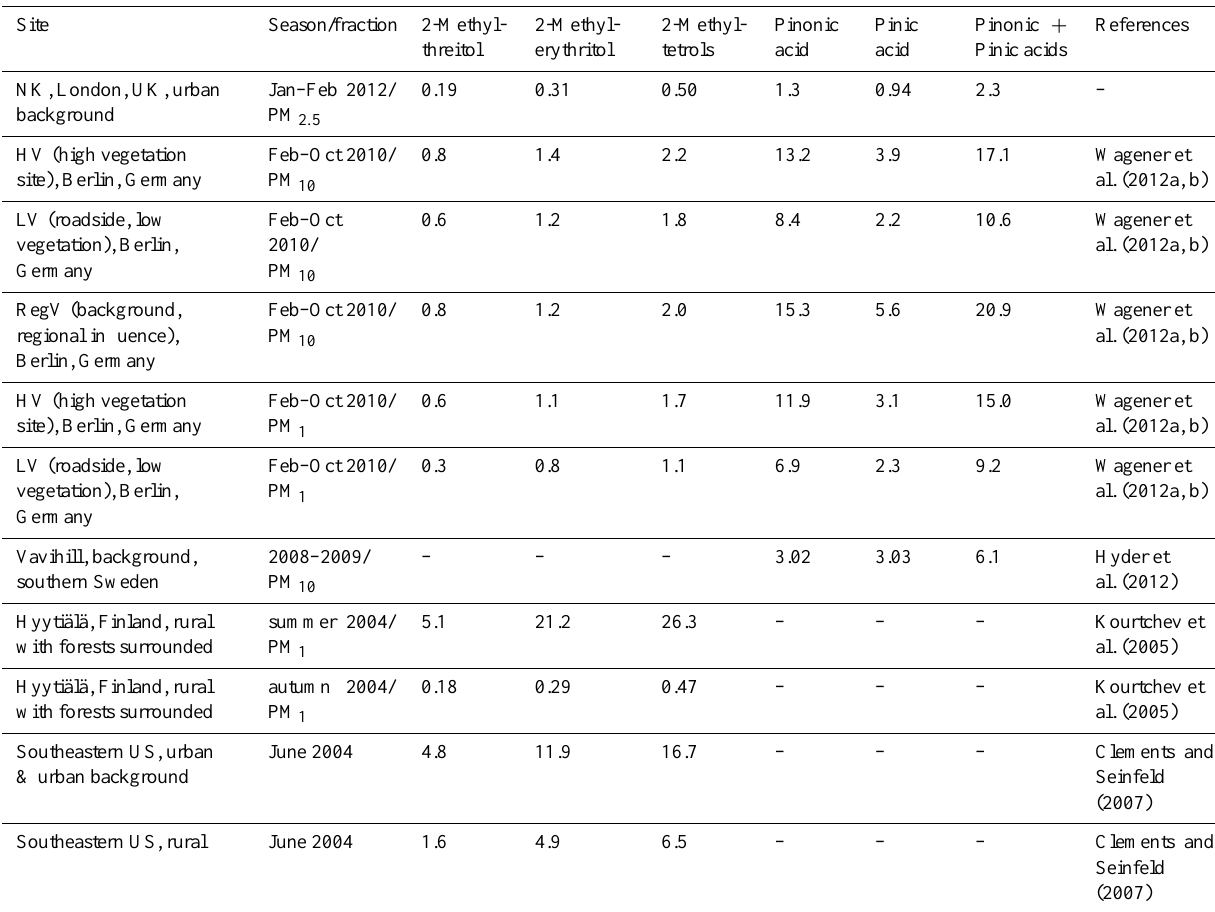
Table 3. Comparison of data for mean concentrations of secondary biogenic molecular markers.